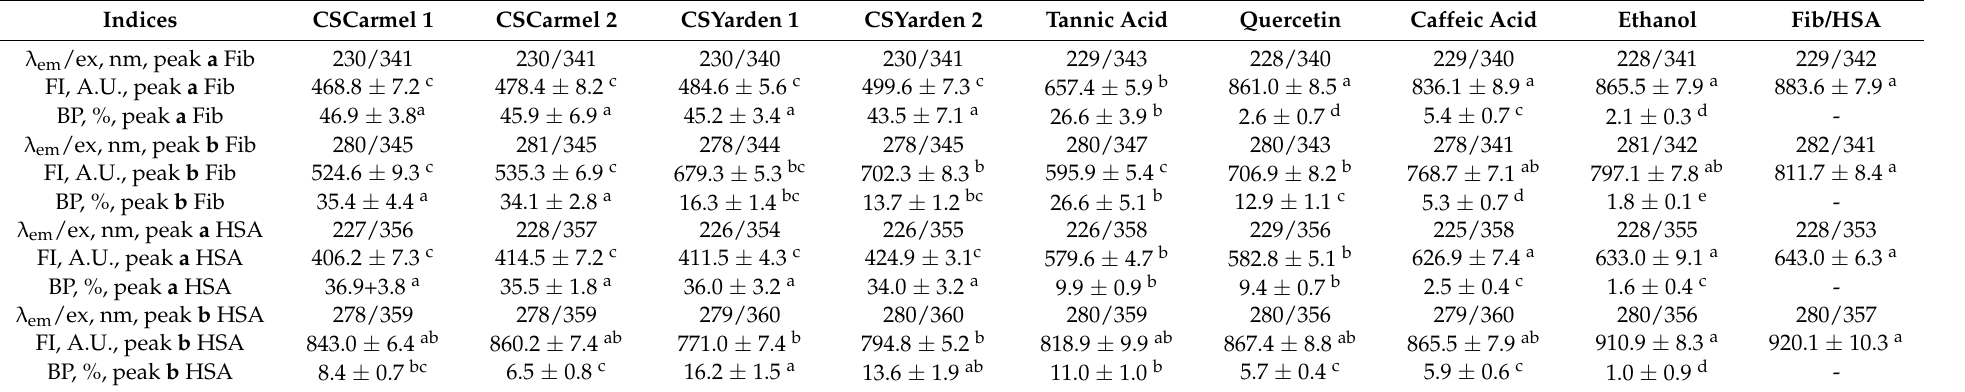
Table 2. Spectral data of the investigated samples and some